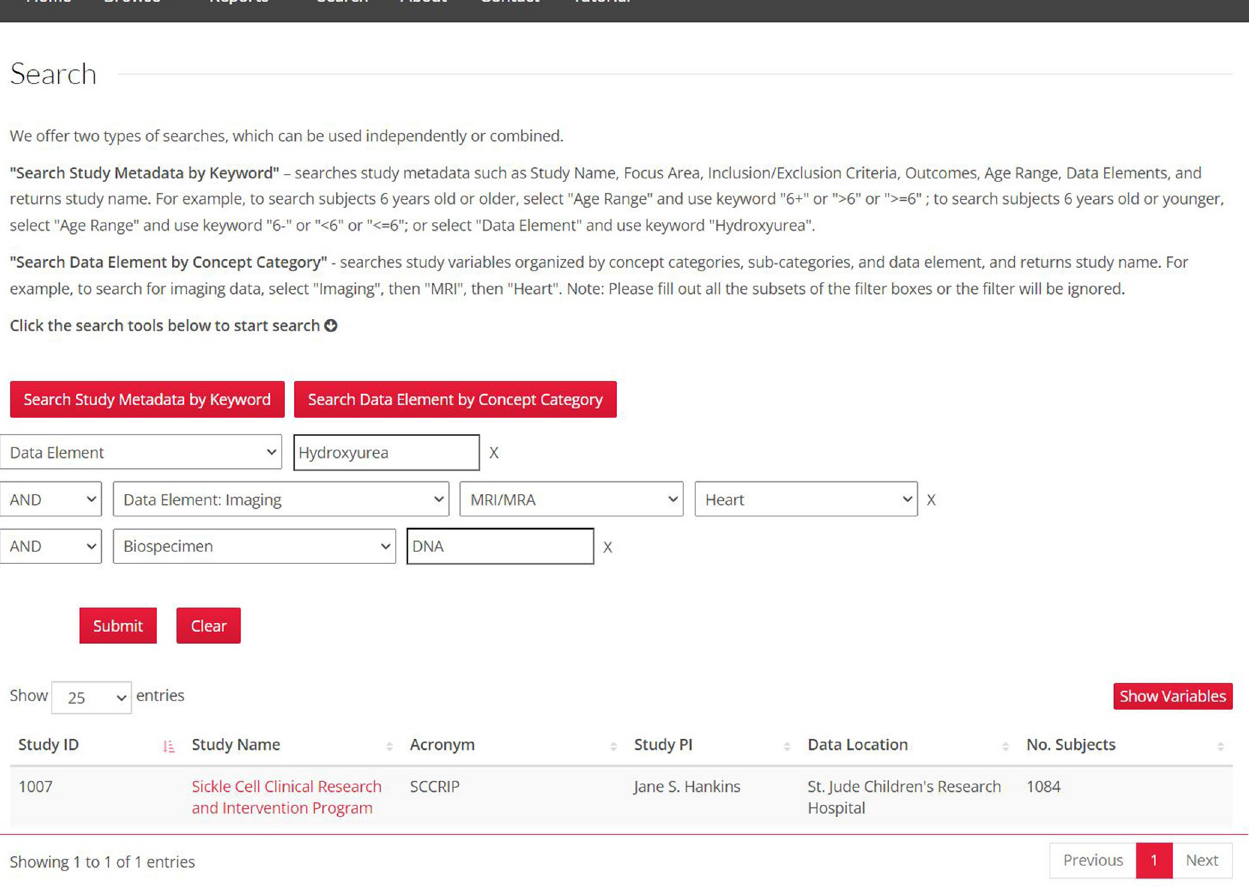
Fig 5. Advanced search combines options to search by keyword and prepopulated conceptual categories. Study identification can be flexibly refined by using keyword searches within a concept category/subcategory/data element or metadata field. The two search modalities may be used independently or in combination with AND/OR/NOT relations. Republished from https://curesicklecell.rti.org/ under a CC BY license, with permission from Public Library of Science (PLOS), original copyright